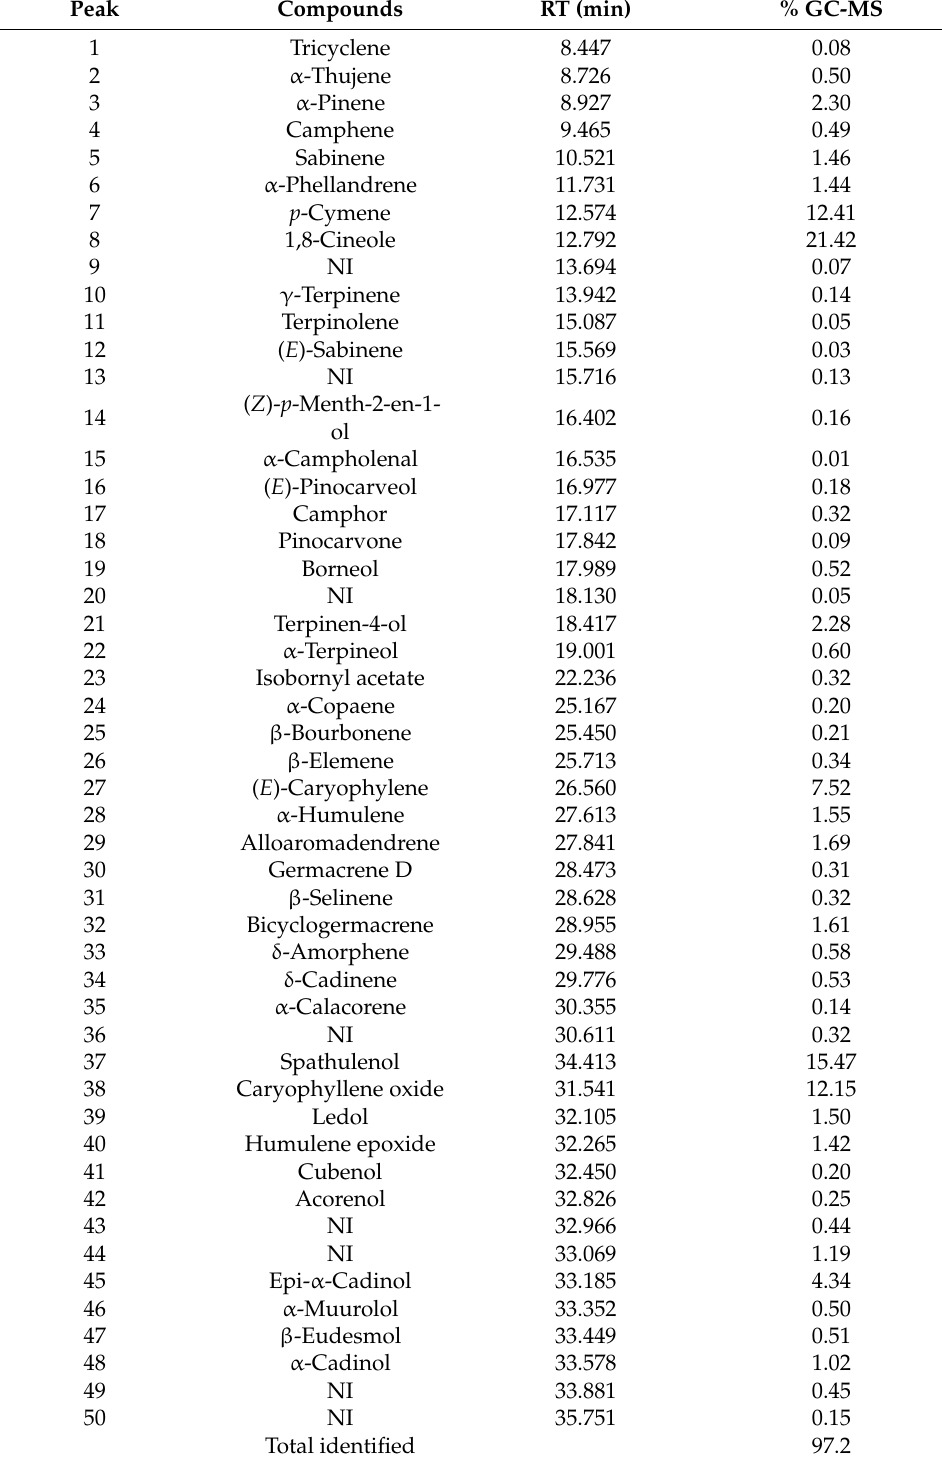
Table 2. Comparison of chemical compounds obtained by GC-MS from the essential oil of fresh. leaves of C. conduplicatus (Oliveira J ú nior et al., 2018).